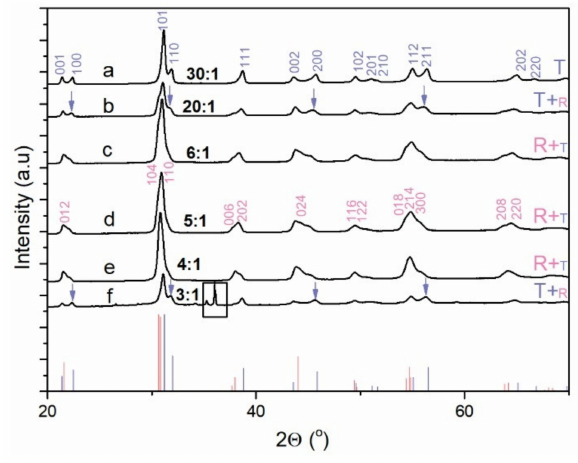
Figure 2. Powder XRD pattern of the PZT reaction product obtained through the one-step precip- itation process and hydrothermal reaction at 235 ◦ C (12 h) from the Zr- and Ti-precursors with the initial Zr/Ti = 60/40 (PZT06) and at ( a ) KOH:Pb = 30:1, ( b ) KOH:Pb = 20:1, ( c ) KOH:Pb = 6:1, ( d ) KOH:Pb = 5:1, ( e ) KOH:Pb = 4:1, and ( f ) KOH:Pb = 3:1. The main diffraction lines of rhombohe- dral ( R ) and tetragonal ( T ) phases were indexed according to ICDD PDF reference code 01-078-4666 and ICDD PDF reference code 04-014-6916, respectively. The prevailing phase is denoted by a larger font. The square designates the diffractions belonging to an unknown phase in the PZT06 sample, obtained at KOH:Pb = 3:1. The blue arrows indicate the occurrence of some characteristic diffractions of the tetragonal phase.